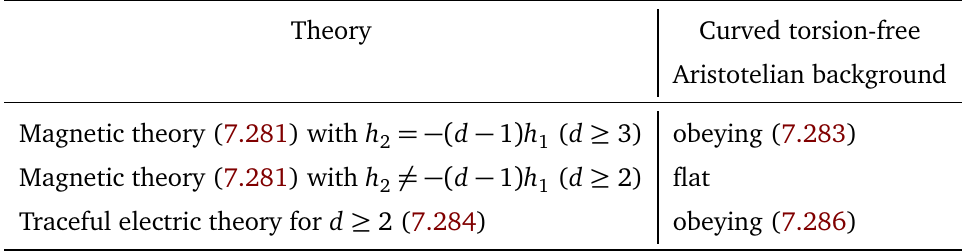
Table 2: Summary of the torsion-free Aristotelian spacetimes to which the scalar charge theories can couple in a gauge-invariant